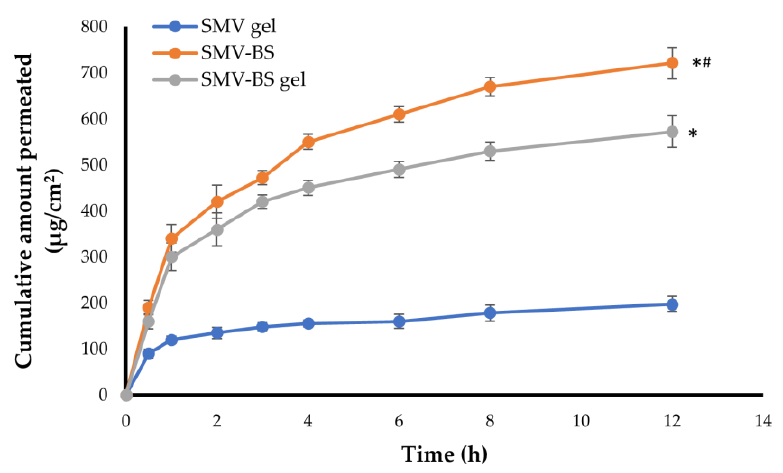
Figure 7. Ex vivo permeation of SMV-BS, plain SMV gel and SMV-BS gel from abdominal rat skin. * p < 0.05 when compared to SMV gel and # p < 0.05 when compared to SMV-BS gel.